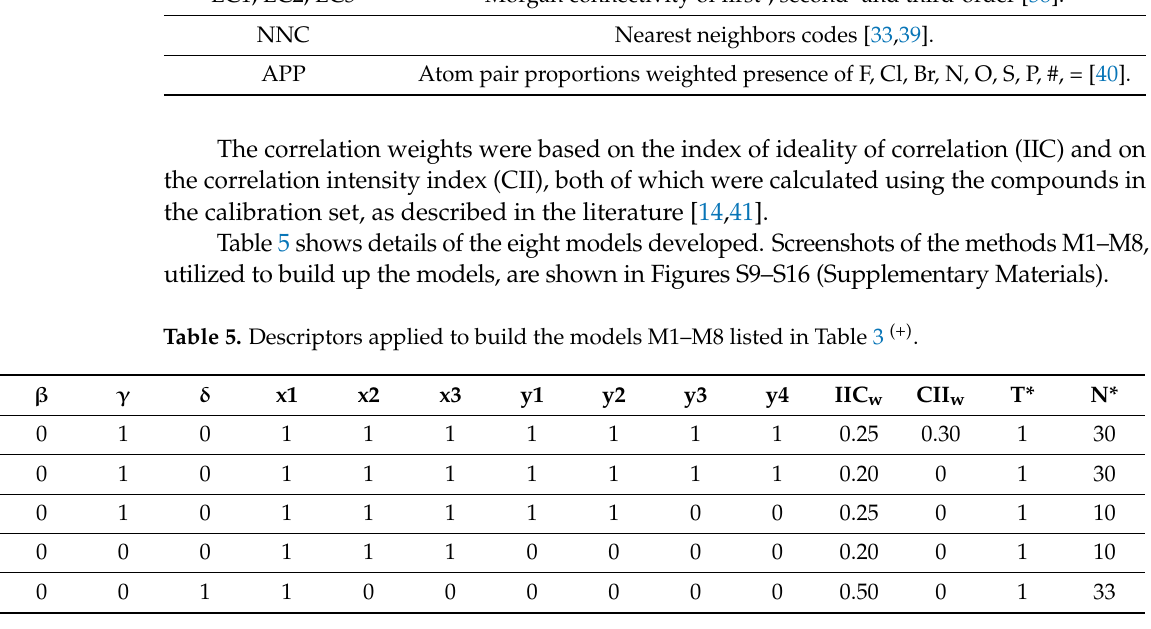
Table 4. SMILES and molecular graph attributes. Attribute Description Single SMILES atom, a combination of two SMILES atoms and a S, SS, SSS combination of three SMILES atoms [36,37]. EC1, EC2, EC3 Morgan connectivity of first-, second- and third-order [38]. NNC Nearest neighbors codes [33,39]. APP